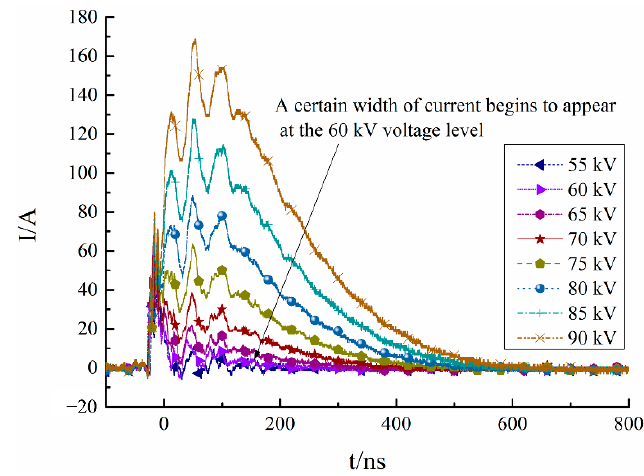
Figure 5. The current passing through